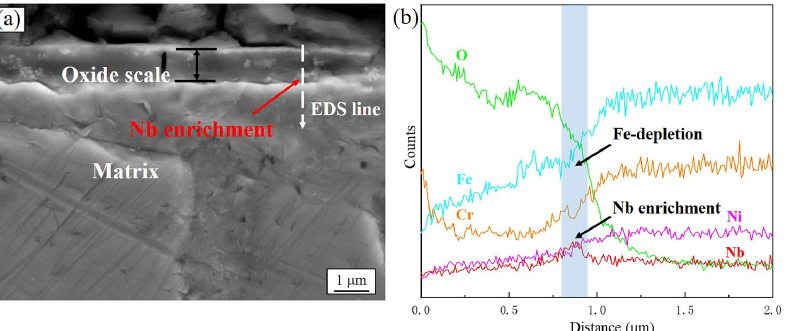
Figure 7. Cross-sectional SEM ( a ) with the corresponding EDS line profile ( b ) images of sample S2 after exposure to CO 2 at 650 °C under 3.5 MPa for 1000 h.